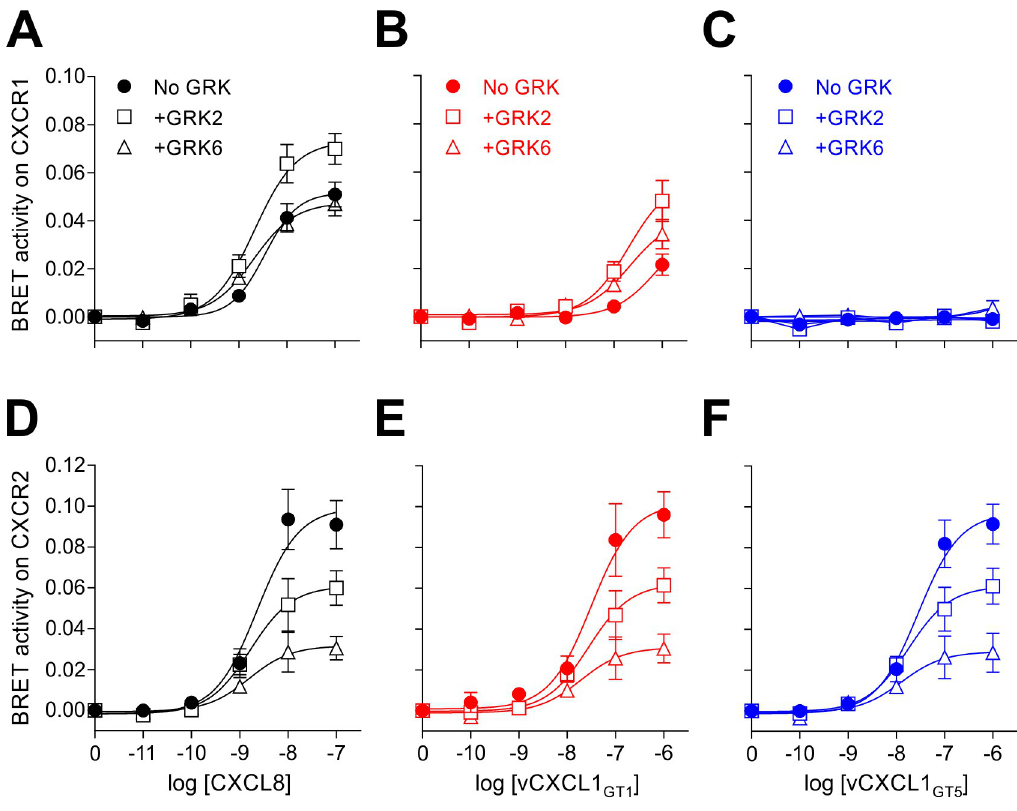
Fig 6. The effect of vCXCL1 GT1 and vCXCL1 GT5 on β -arrestin recruitment through CXCR1 and CXCR2 with/without GRKs. Agonism of CXCL8 (A+D) , vCXCL1 GT1 (B+E) , and wild-type vCXCL1 GT5 (C+F) on the β -arrestin recruitment pathway of CXCR1 and CXCR2 in a BRET-based assay without GRKs (circle, ● ), with GRK2 (square, ■ ), and with GRK6 (triangle, ▲ ); n = 3–4. Error bars presented as